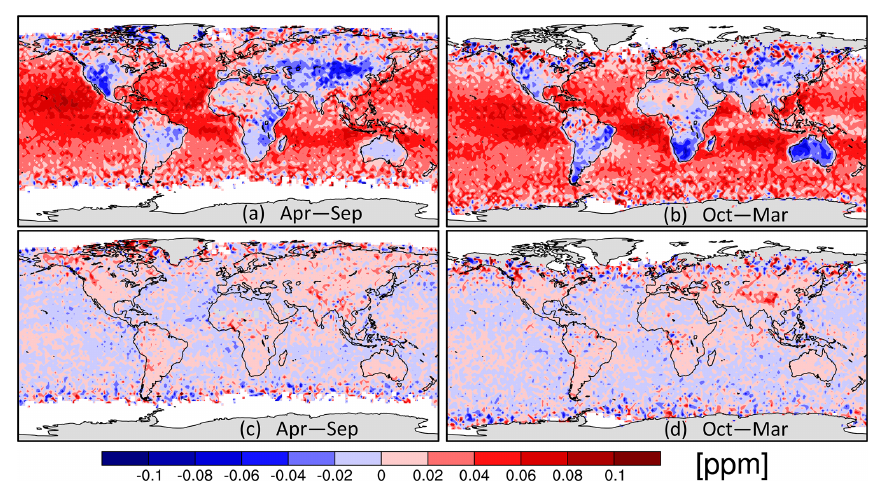
Figure 6. The difference or shift [ppm] in X CO from the two-step average shown in Fig. 5 given by the one-step information average (given 2 by summing all the good scenes within each 10s span without first computing 1s averages) (a, b) and by the exponential correlation model (c, d) for April–September and October–March.